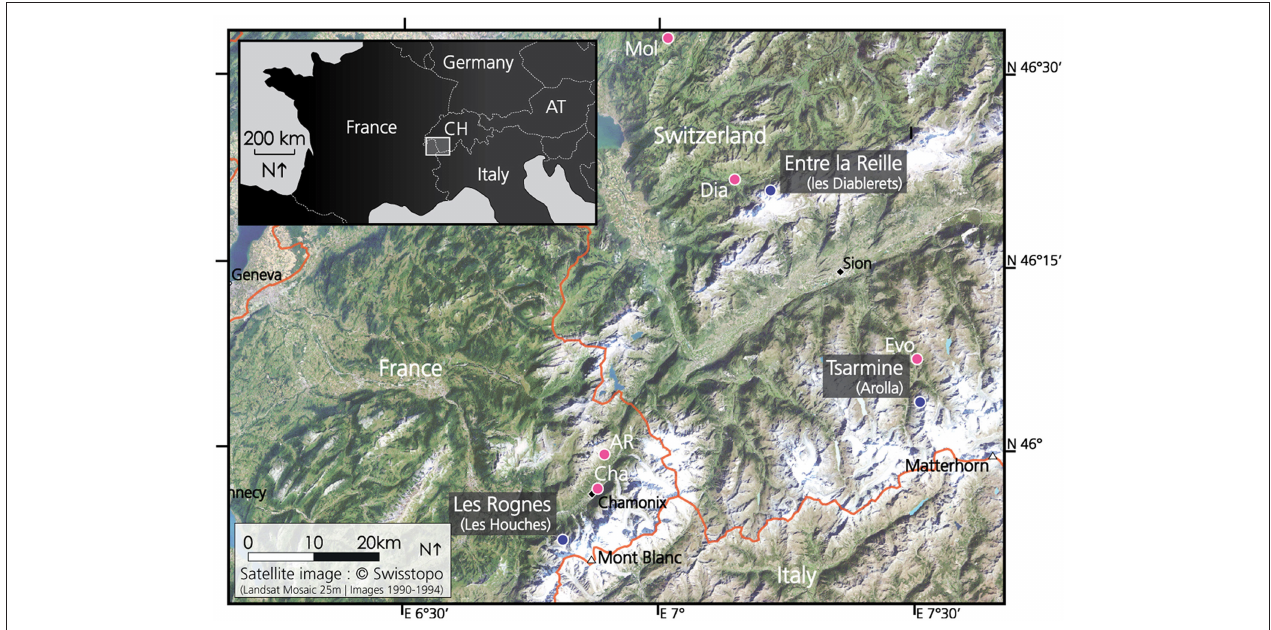
FIGURE 1 | Satellite image of the northwestern Alps showing the location of the three glacier systems studied. The red dots refer to weather